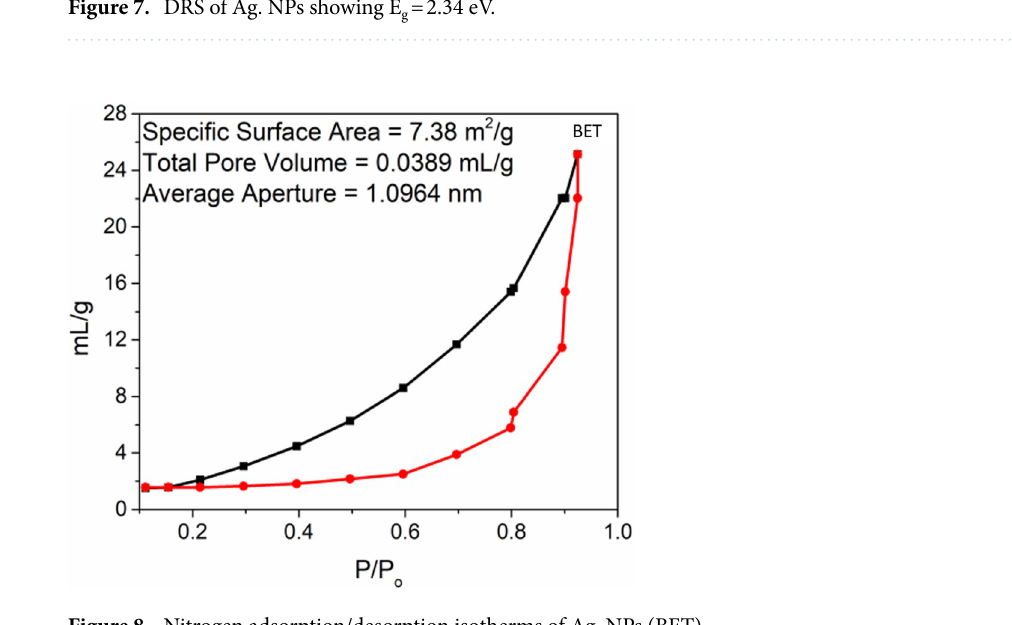
Figure 7. DRS of Ag. NPs showing E g = 2.34 eV.